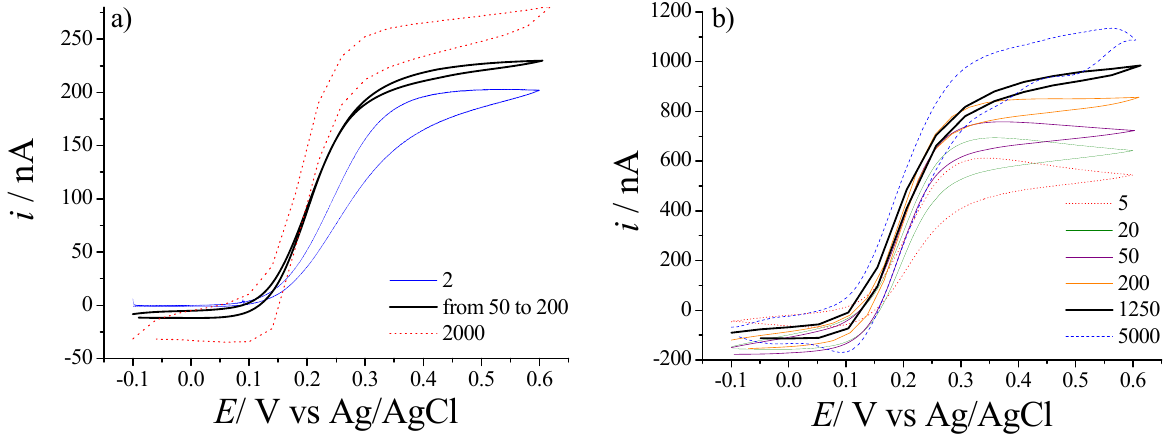
Figure 5. Cyclic voltammograms recorded in a solution of 1.0 mM K 0.1M KNO at different scan rates. a) UMEA with 5 µm disk diameter and 100 µm inter- 3 electrode distance at a scan rate of 2, 50 to 200 and 2,000 mV.s -1 , b) UMEA 5 µm disk diameter and 50 µm inter-electrode distance at scan rate of 5, 20, 50, 200, 1,250 and 5,000 mV.s -1 .